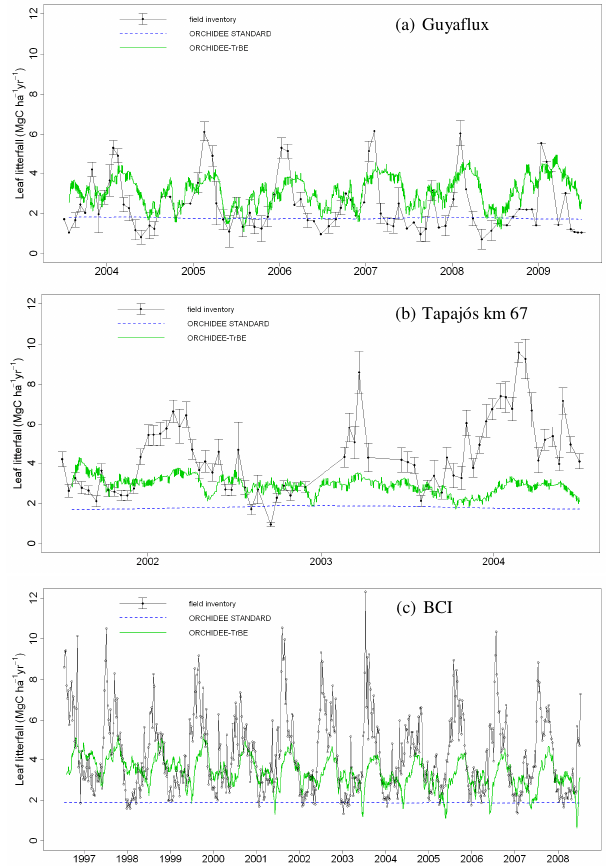
Fig. 4. Modelled and measured seasonal patterns of leaf litterfall Figure 4. Modeled and measured seasonal patterns of leaf litterfall (MgC ha -1 yr -1 ). (MgCha − 1 yr − 1 ). Field inventory measurements are compared Field inventory measurements are compared with the standard model and the modified with the standard model and the modified ORCHIDEE-TrBE leaf ORCHIDEE-TrBE leaf litterfall at (a) Guyaflux from 2004 to 2009 (b) Tapajós km 67 litterfall at (a) Guyaflux from 2004 to 2009 (b) Tapaj´os (km 67) from 2002 to 2004 (c) and Barro Colorado Island, Panama from 1997 to 2008. from 2002 to 2004 (c) and Barro Colorado Island, Panama from 1997 to 2008.